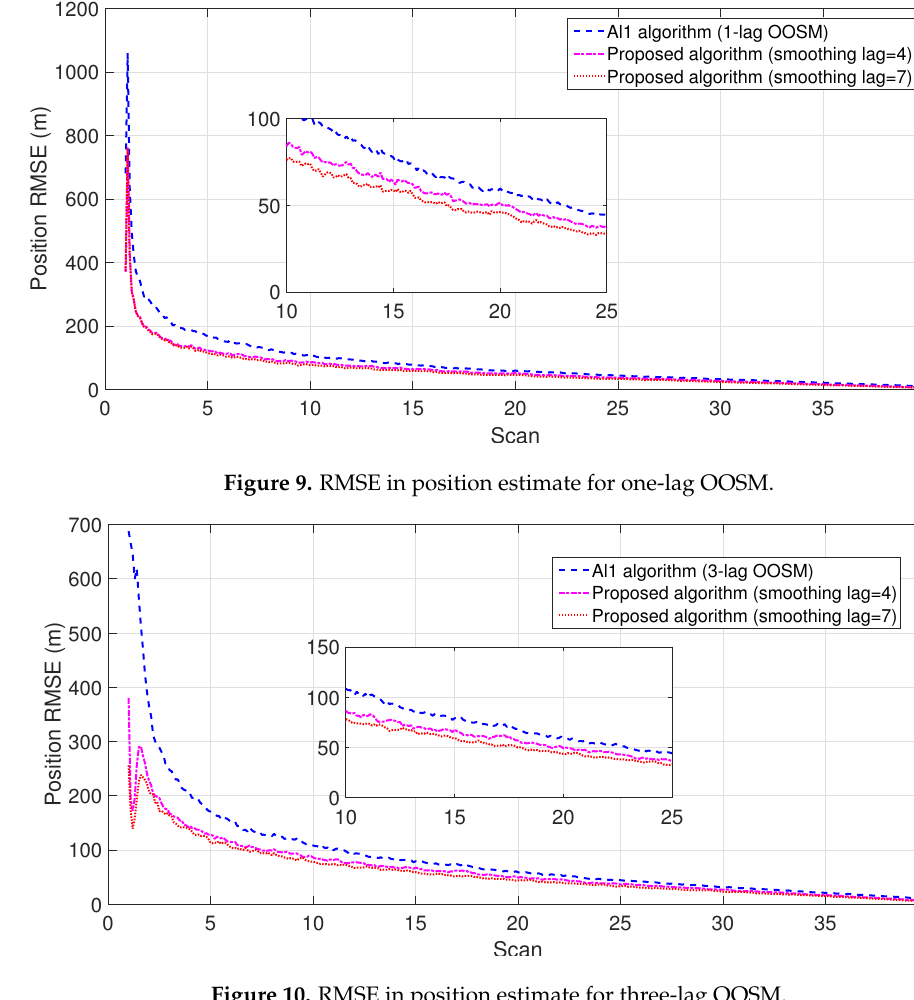
Al1 algorithm (5-lag OOSM) Proposed algorithm (smoothing lag=4) Proposed algorithm (smoothing lag=7)